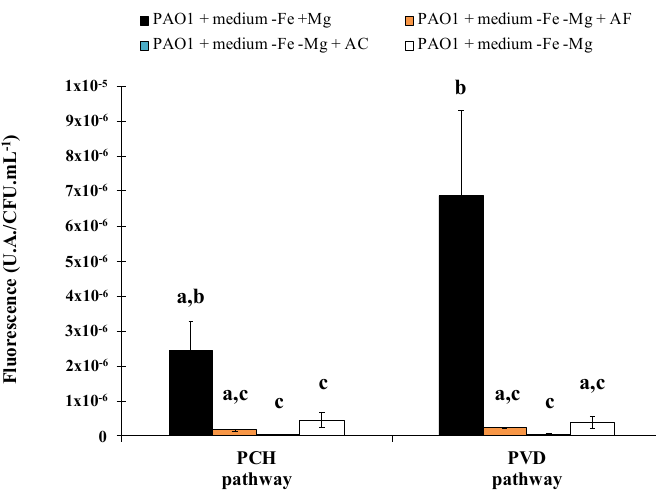
Figure 4. Biosynthetic enzymes for pyoverdine and pyochelin production were tagged with fluorescent protein mCherry to follow the synthesis of proteins involved in siderophore production (PVDJ for pyoverdine and PchA for pyochelin). Bars represent the expression of the pyoverdine and pyochelin biosynthetic pathways after 24 h of Pseudomonas aeruginosa PAO1 growth in casamino acids medium restricted in iron ( − Fe) with ( + Mg) or without ( − Mg) magnesium, in the presence or absence of asbestos flocking (AF) or asbestos cement (AC). P. aeruginosa PAO1 growth in medium − Fe + Mg and − Fe − Mg corresponds, respectively, to the positive and the negative control. Error bars indicate the standard errors of the means of three, five or six replicates. Bars with the same letter are not significantly di ff erent ( p ≥ 0.05, Kruskal–Wallis test, three, five or six replicates). Adapted from David et al. [79,80].